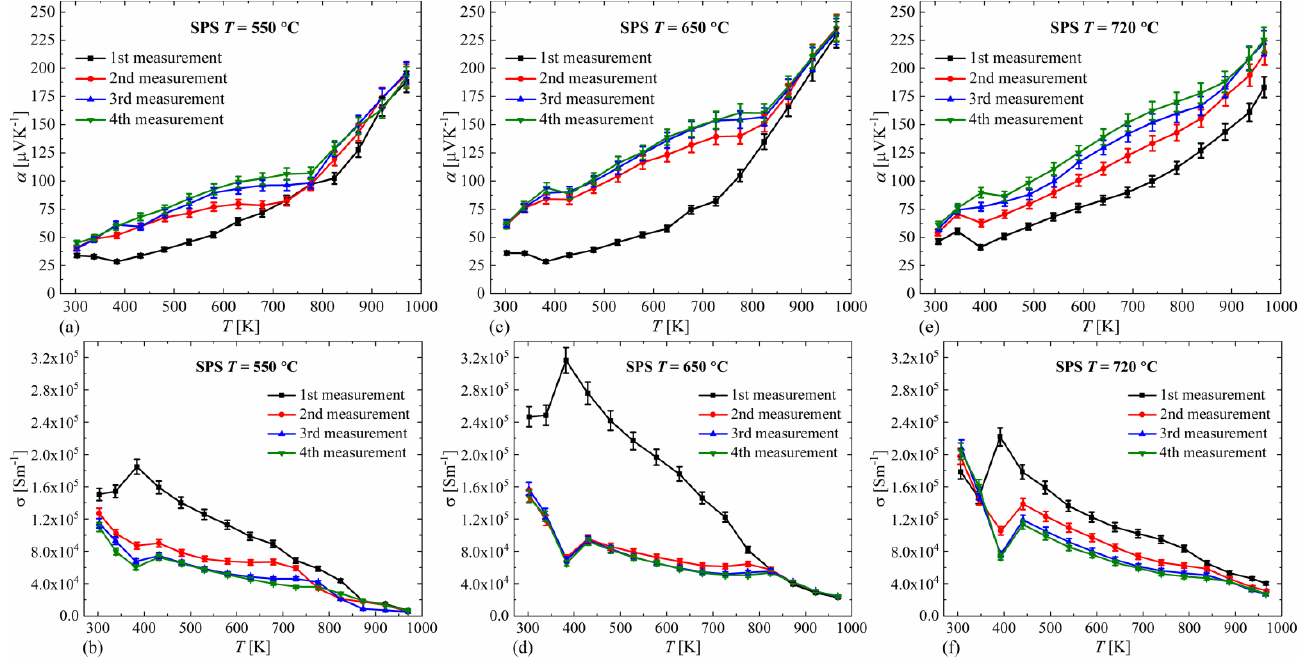
Figure 5. Temperature dependence of the Seebeck coefficient and the electrical conductivity for Cu 2 Se samples sintered at 550 °C ( a,b ), 650 °C ( c , d ), 720 °C ( e , f ) (absolute errors for α r = 0.05).